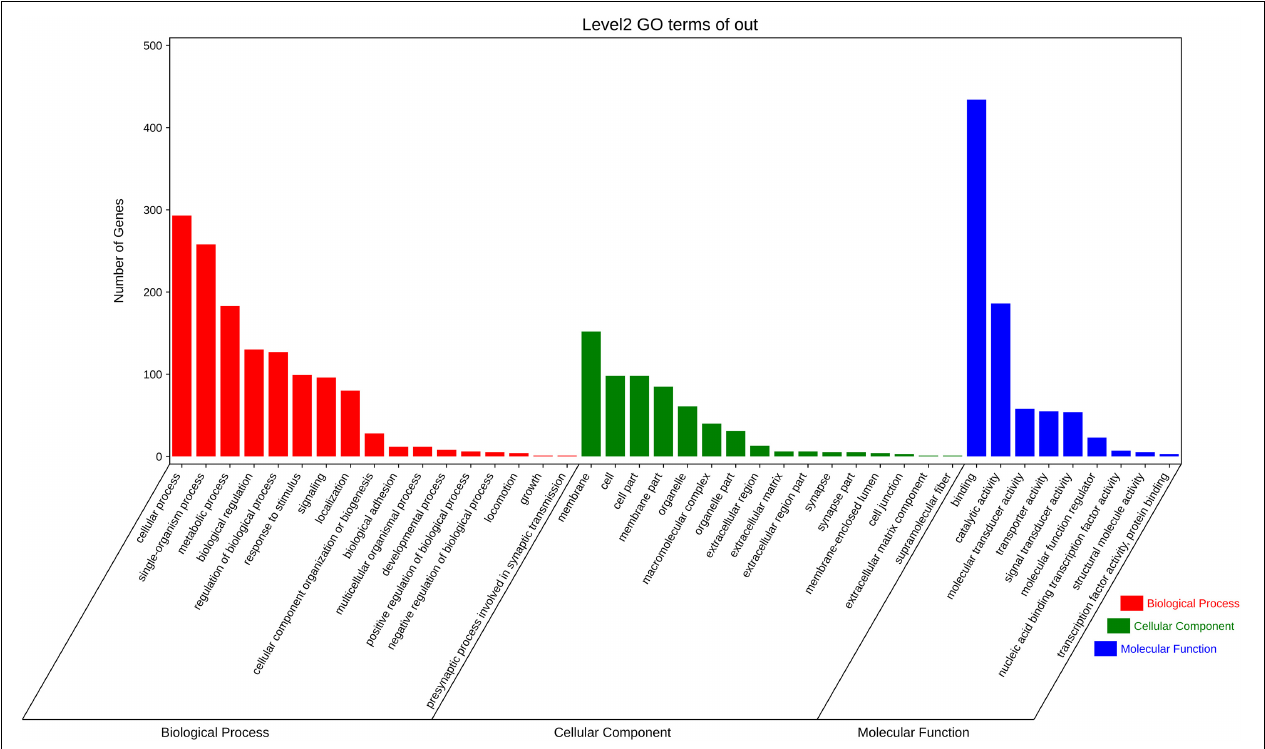
FIGURE 3 | The summary of GO function annotation analysis for candidate selective genes that comprised significant SNPs ( P < 0.05). Each term described the function of gene cluster and the length of colored bars represent the numbers difference of genes.